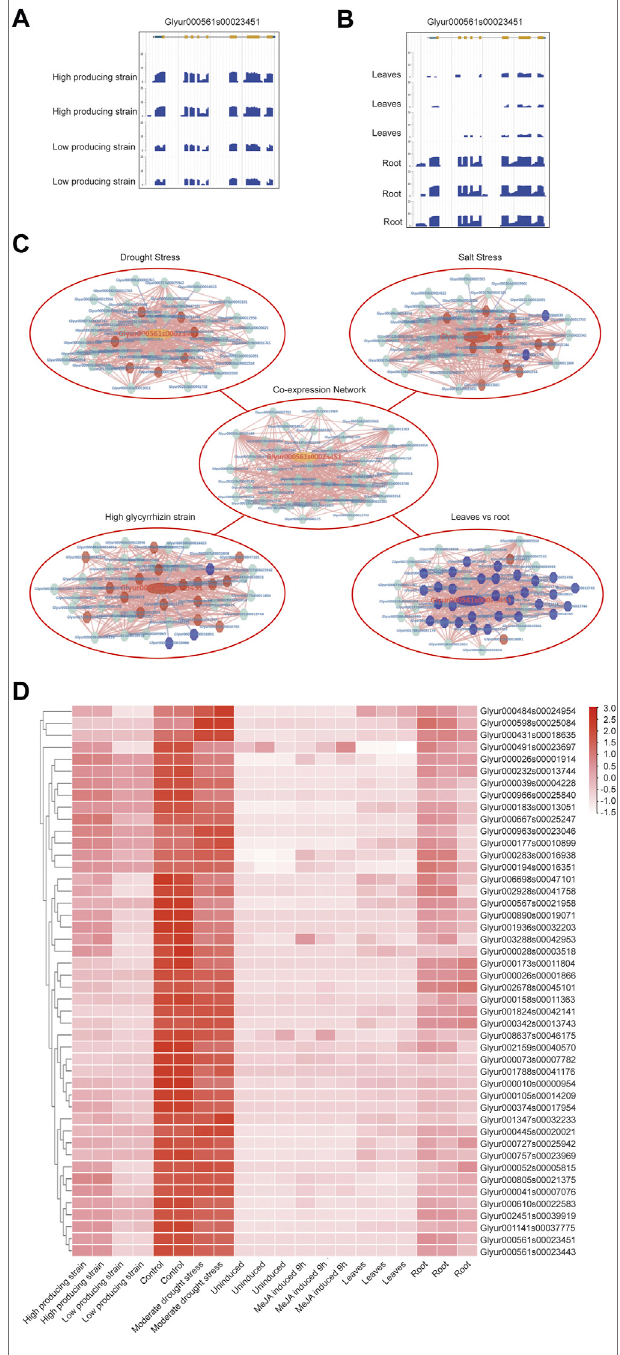
FIGURE 5 | Functional analysis for CYP88D6 gene. (A) CYP88D6 expression in high producing and high producing lines of glycyrrhizin uralensis insummerdisplayedbyJBrowse. (B) CYP88D6expression inleavesandroot of glycyrrhizinuralensis displayedbyJBrowse. (C) Theup-regulationand down-regulation of CYP88D6 co-expressed genes in different conditions, red represent up-regulation and blue represent down-regulation. (D) The expression levels of CYP88D6 co-expressed genes in different samples displayed by heatmap.